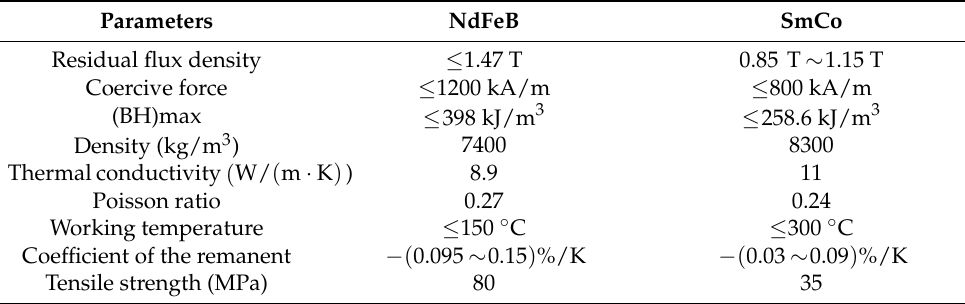
Table 7. Performance of permanent magnet materials for